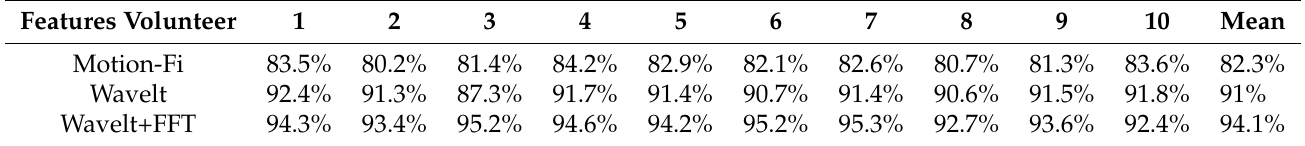
Table 2. Recognition comparison of MobiFit, Motion-Fi [15].